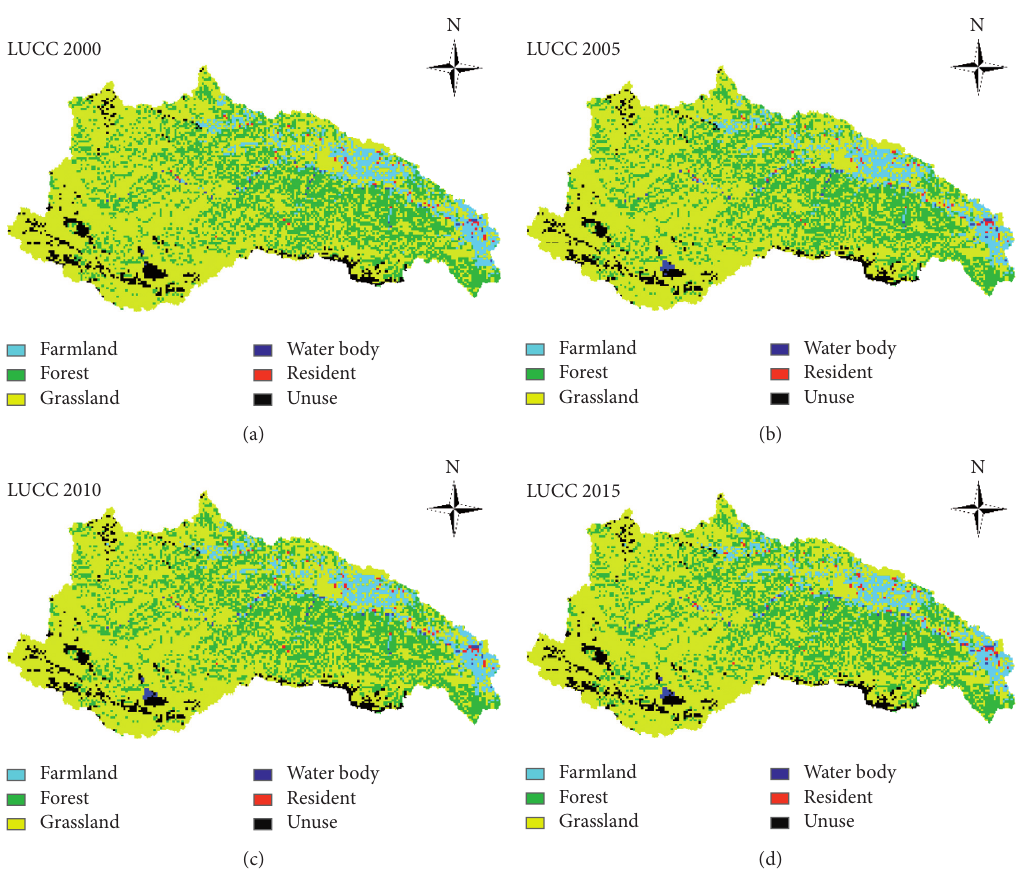
Figure 11: Spatial distributions of land use from the dataset of years 2000, 2005, 2010, and 2015 in the upper Taohe River basin.